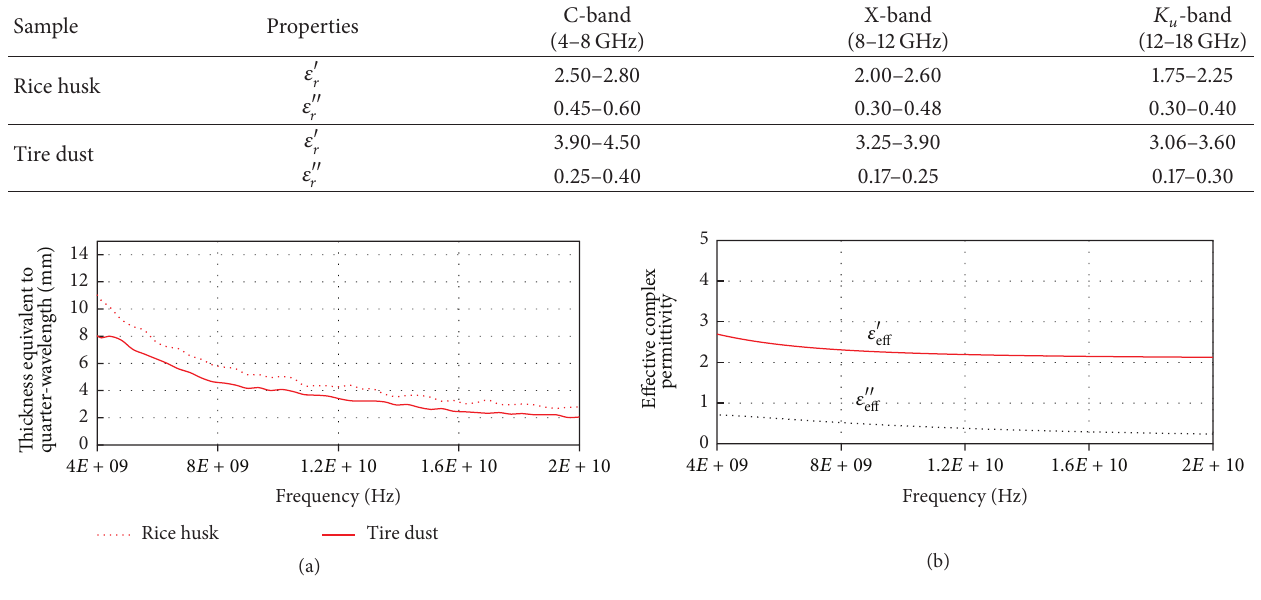
Figure 5: (a) Thickness equivalent to the quarter-wavelength based on the measured dielectric properties for rice-husk and rubber tire-dust material. (b) Calculated effective dielectric properties for hollow pyramidal absorber for wall thickness of 10mm and fill factor 𝑔 = 0.32